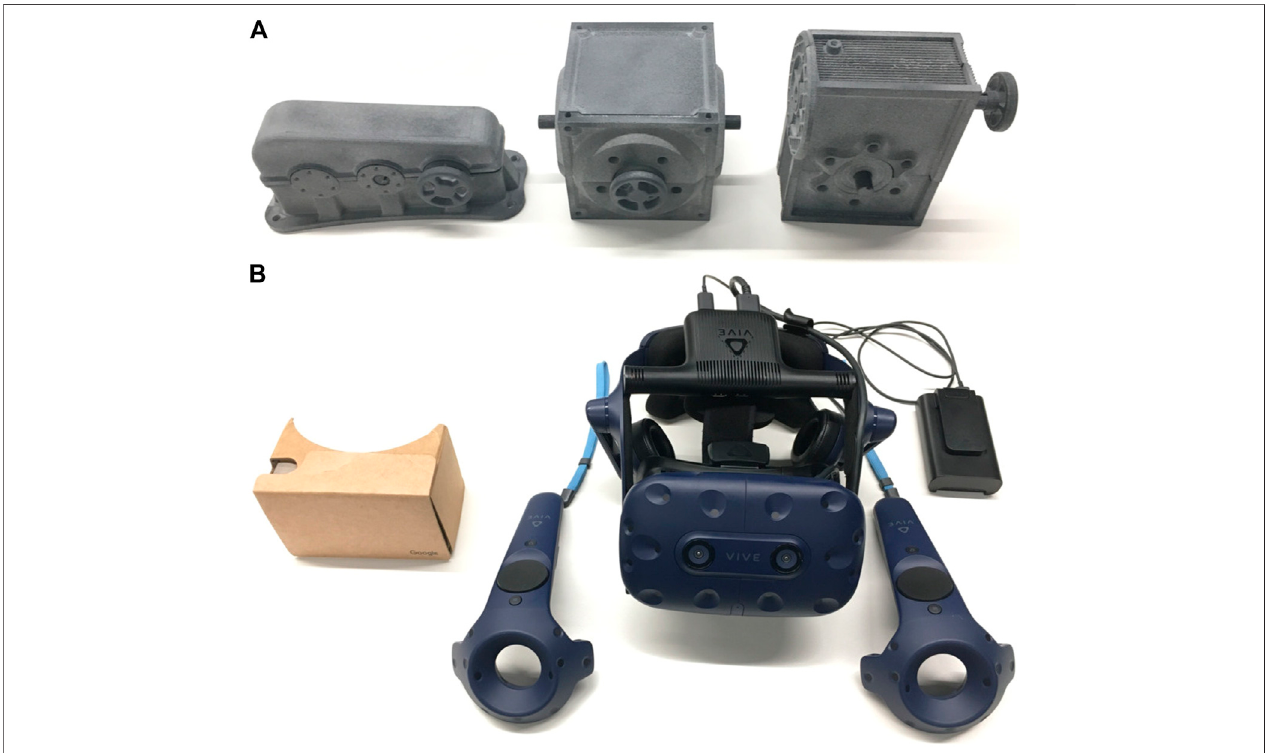
FIGURE 2 | (A) 3D-printed gearboxes, and (B) cost-differentiated VR systems.